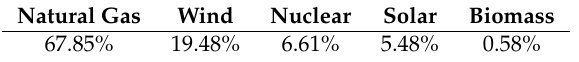
Table 6. Percentage of resources used during peak and off-peak hours in the Netherlands [51]. Natural Gas Wind Nuclear Solar